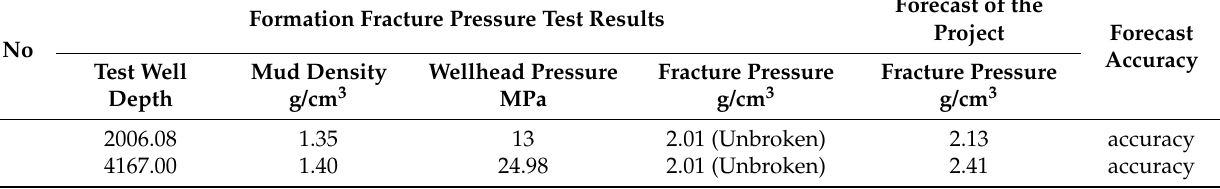
Table 2. Comparison table of formation fracture pressure prediction results and actual drilling data of Yuanba 12